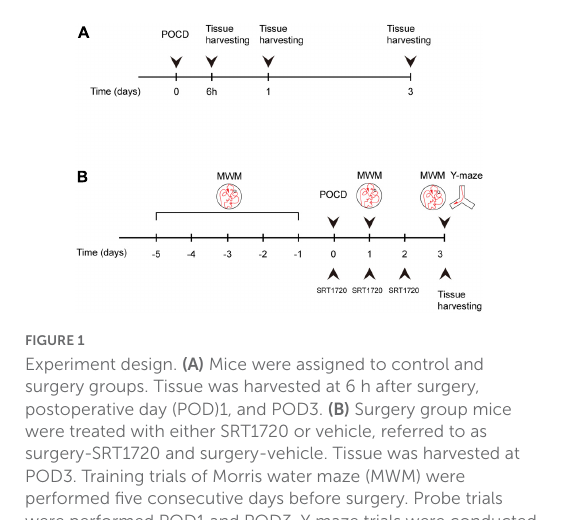
FIGURE1 Experiment design. (A) Mice were assigned to control and surgery groups. Tissue was harvested at 6 h after surgery, postoperative day (POD)1, and POD3. (B) Surgery group mice were treated with either SRT1720 or vehicle, referred to as surgery-SRT1720 and surgery-vehicle. Tissue was harvested at POD3. Training trials of Morris water maze (MWM) were performed five consecutive days before surgery. Probe trials were performed POD1 and POD3. Y maze trials were conducted on